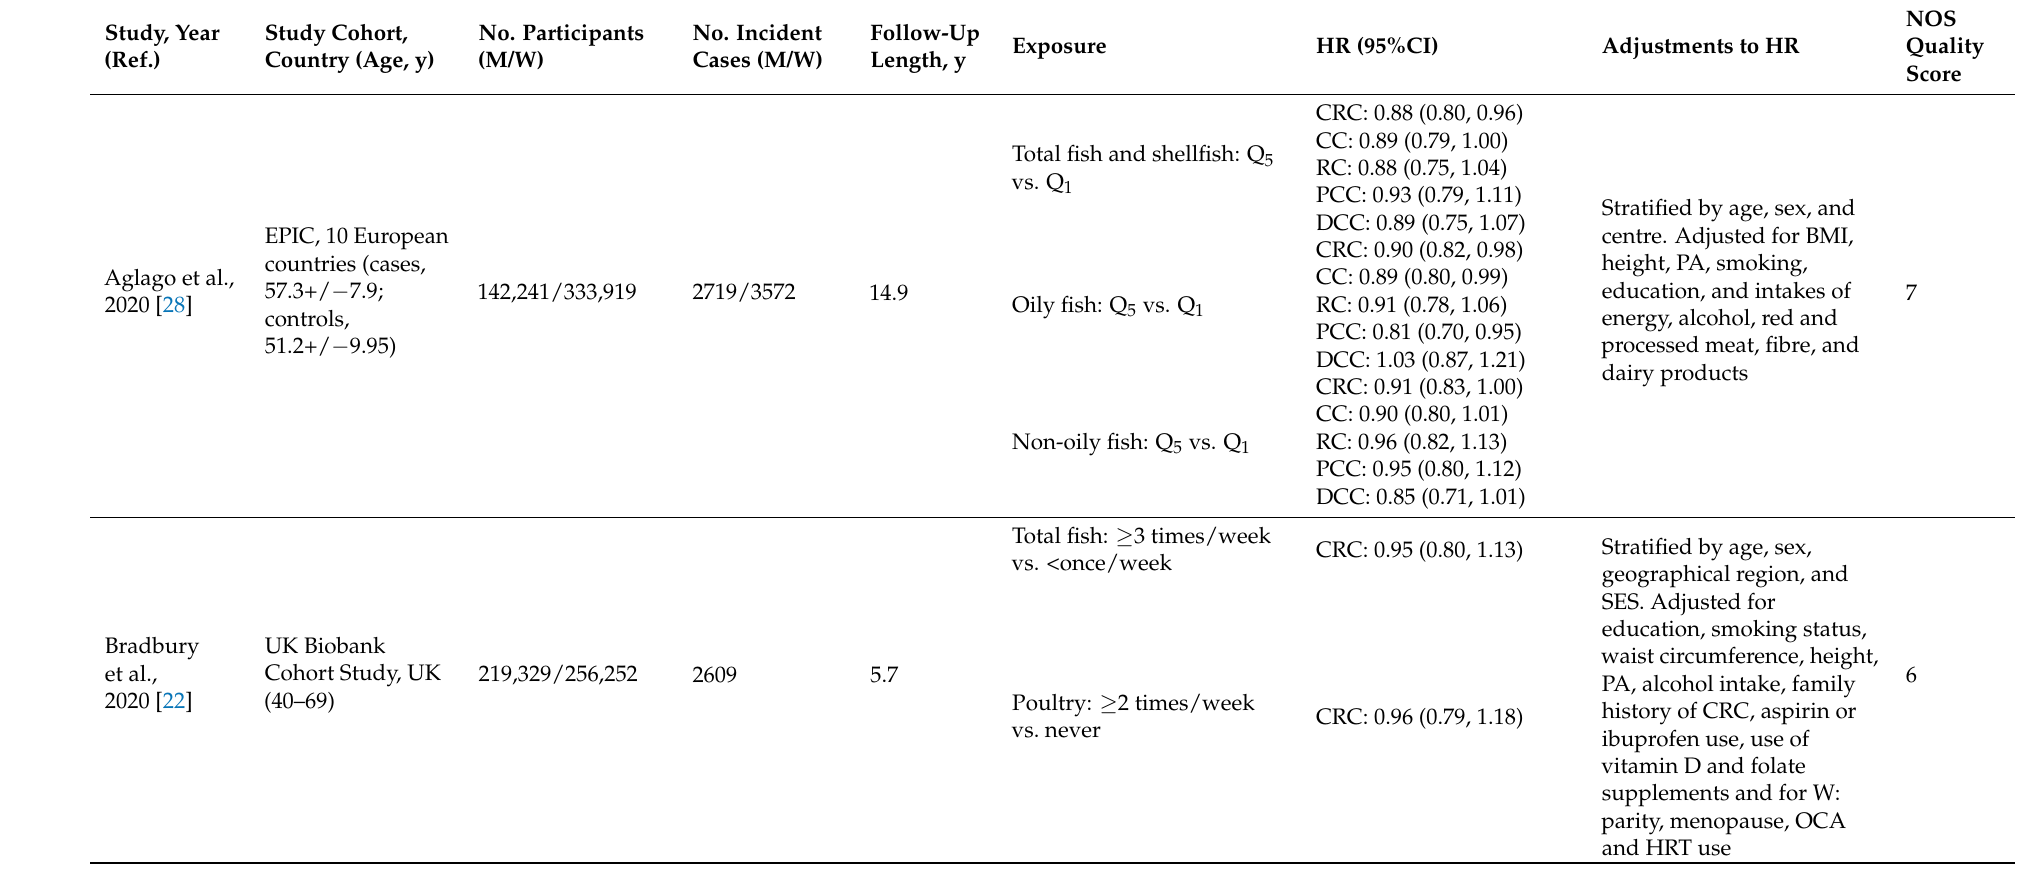
Table 4. Characteristics of the five cohort studies included in the systematic review examining the association between the consumption of fish, white meat, and eggs and the risk of colorectal